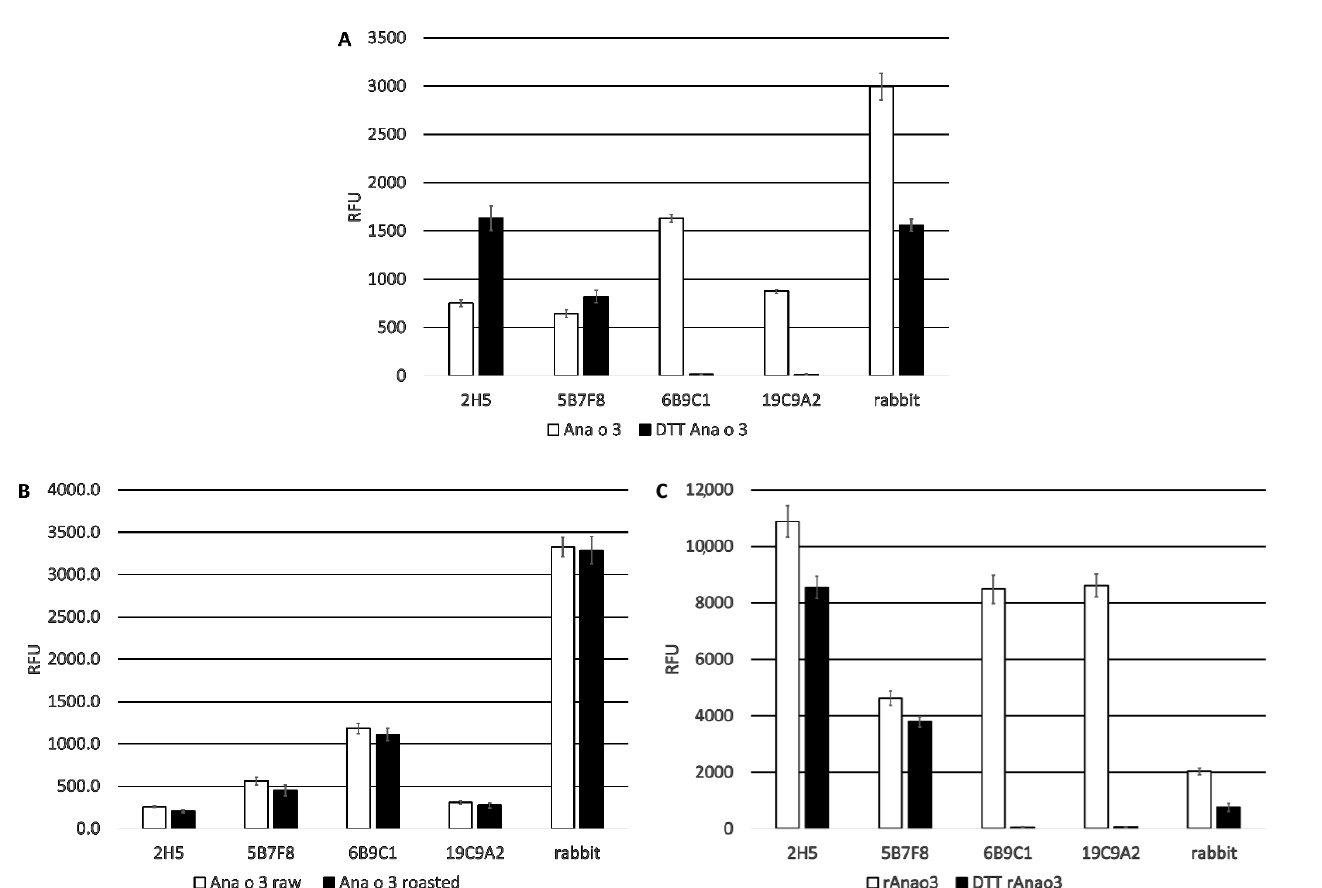
Antibodies 2021 , 10 , x FOR PEER REVIEW 7 of 16 Figure 2. Specificity of anti-Ana o 3 monoclonal antibody binding to native or DTT treated peanut, cashew, pistachio, pecan, walnut, and almond nut extracts. Relative fluorescence units (RFU) are indicated on the y -axis. Data represent the average of at least four independent samples, and error bars included show ± standard deviation. Graphs represent ELISA values for ( A ) 2H5, ( B ) 5B7F8, ( C ) 6B9C1, and ( D ) 19C9A2 monoclonal antibodies. The four monoclonal antibodies were also evaluated for recognition of purified Ana o 3 (4 µg). Both the 2H5 and 5B7F8 antibodies showed significantly ( p < 0.01 Tukey HSD) increased recognition of purified native Ana o 3 after DTT treatment (Figure 3A).